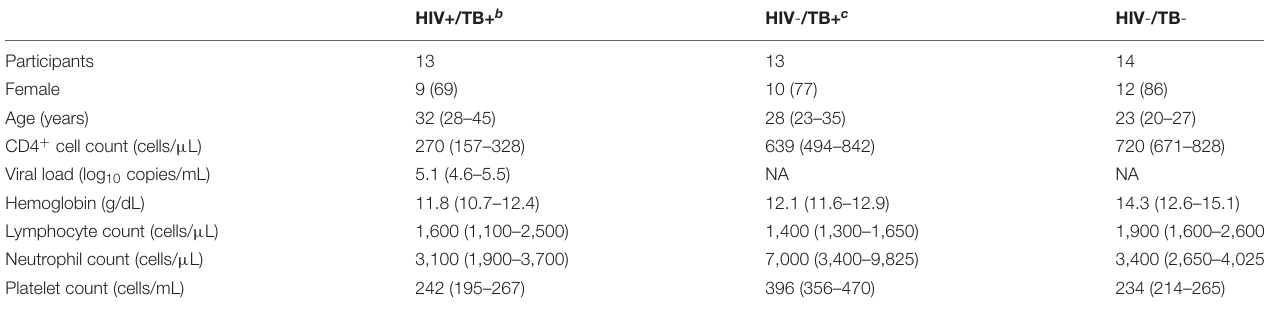
TABLE 1 | Study participant characteristics a